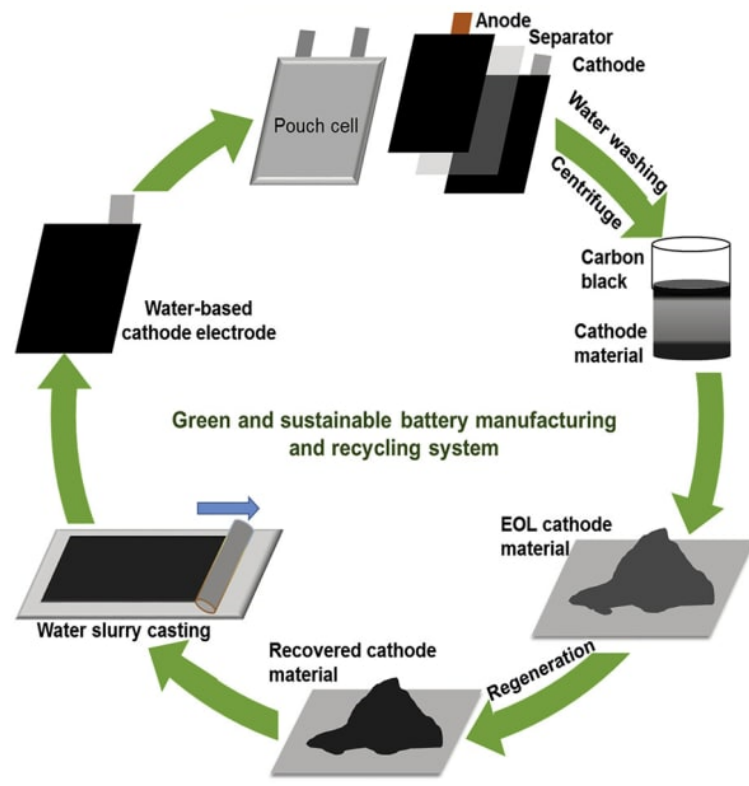
Figure 7. Schematic of the battery green manufacturing and direct recycling process to form the circular supply chain [12].